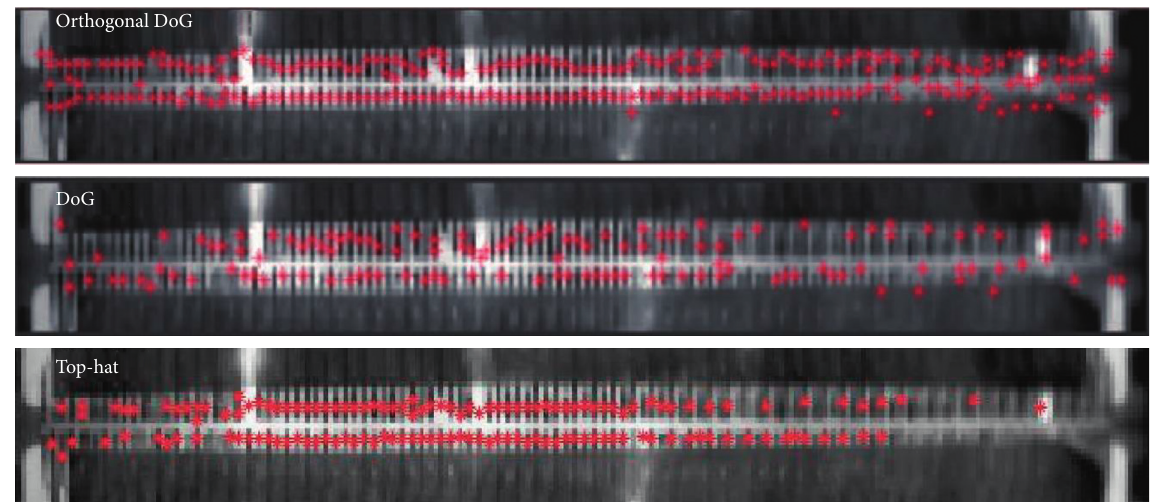
Figure 13: Candidate targets with the improved orthogonal DoG filter, DoG filter, and the top-hat filter. (a) Orthogonal DoG. (b) DoG. (c) Top-hat.